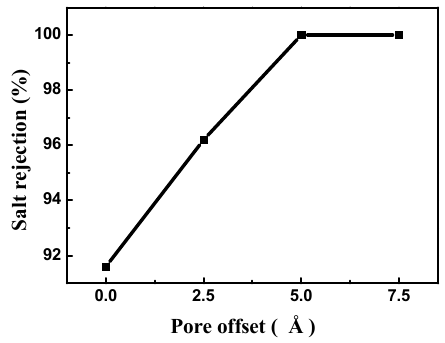
Figure 9. Salt rejection of the bilayer porous graphene membrane for different pore offsets.